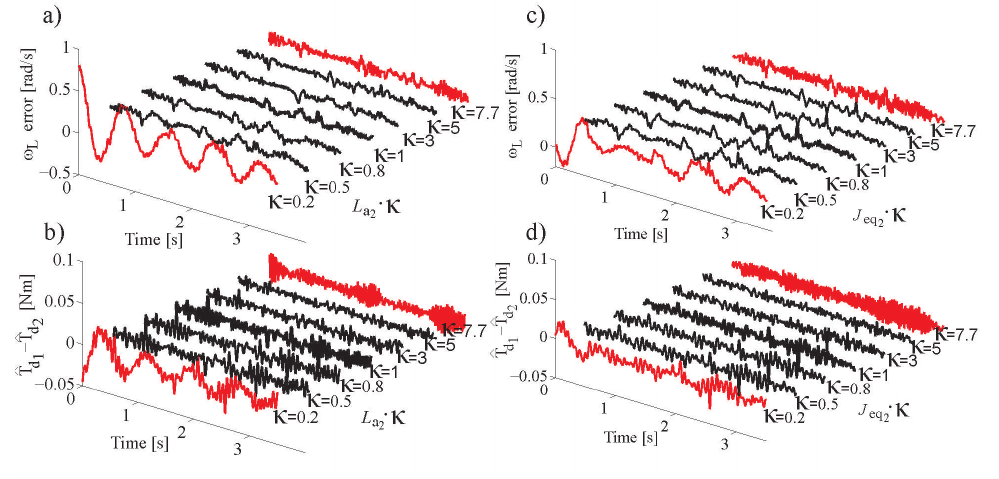
Figure 12. Variation of L a 2 : ( a ) ω L − ω ∗